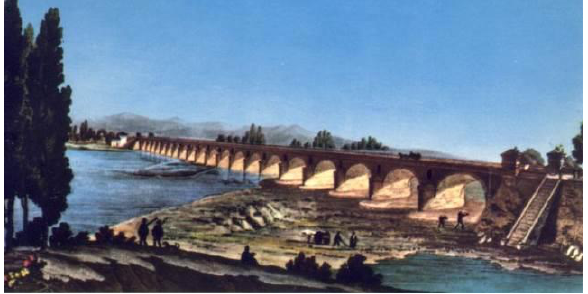
Figure 1. A historical view of the Ponte Taro